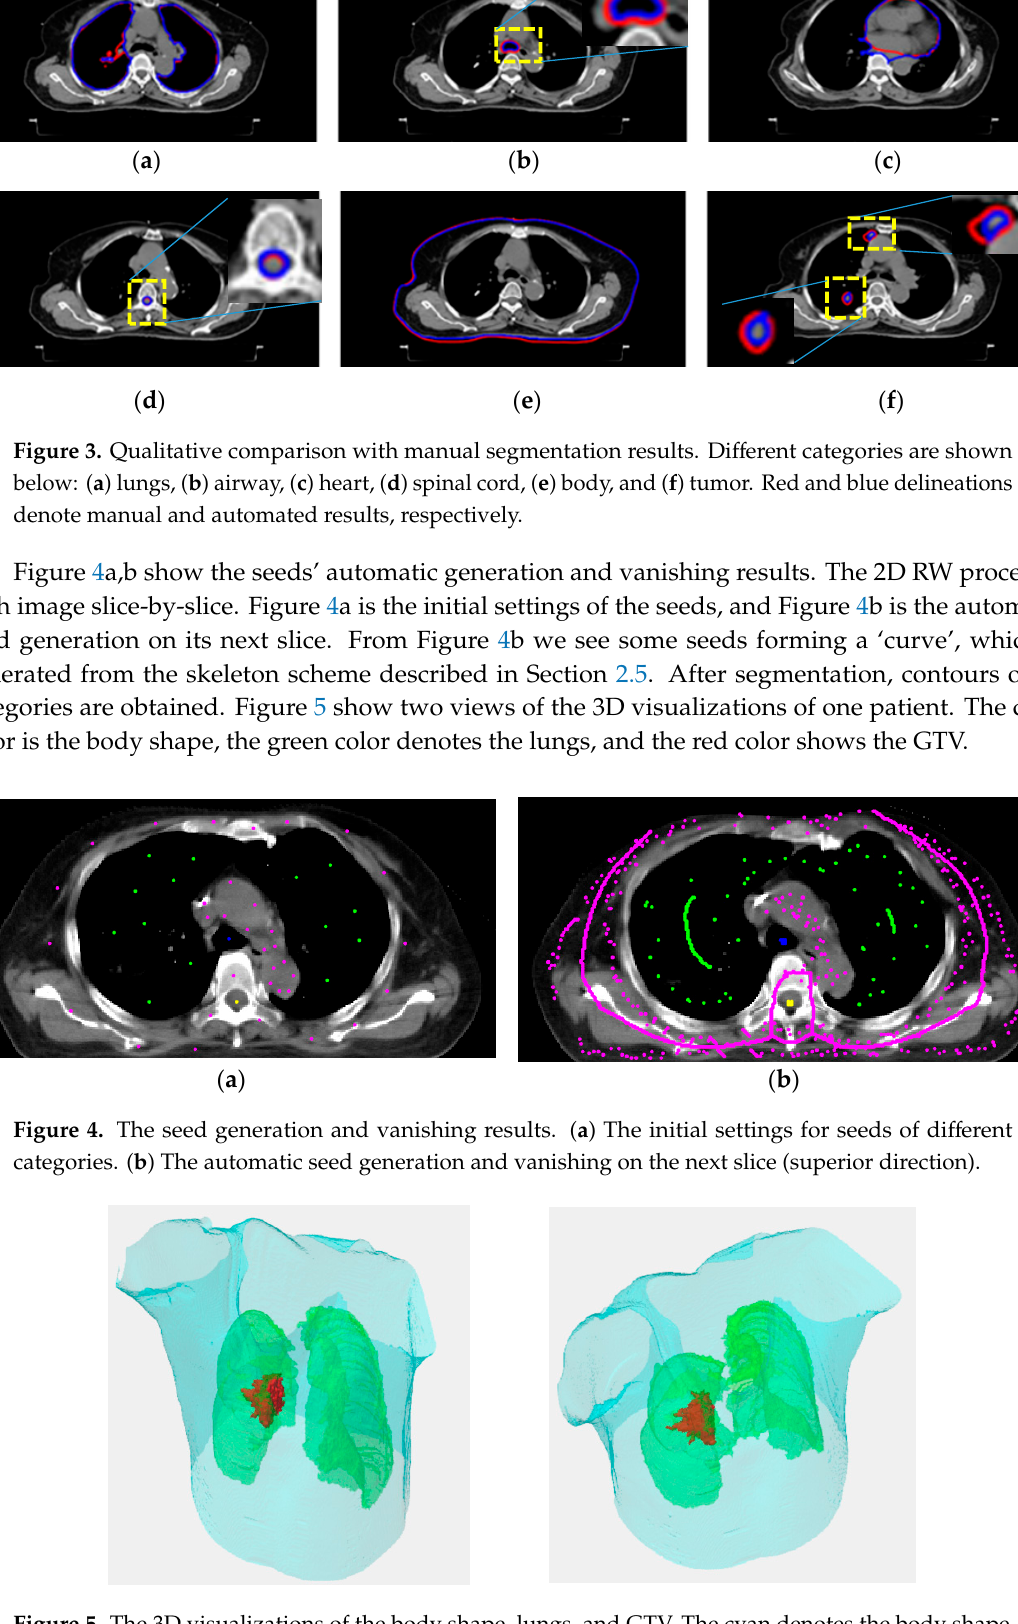
( d ) Figure 2. ( a ) The raw image with some initial seeds. ( b ) The RW segmentation result. ( c ) The automated delineations superimposed on the raw image. ( d ) The segmented lung area with seeds superimposed on the result. 3.2. Automated Segmentation